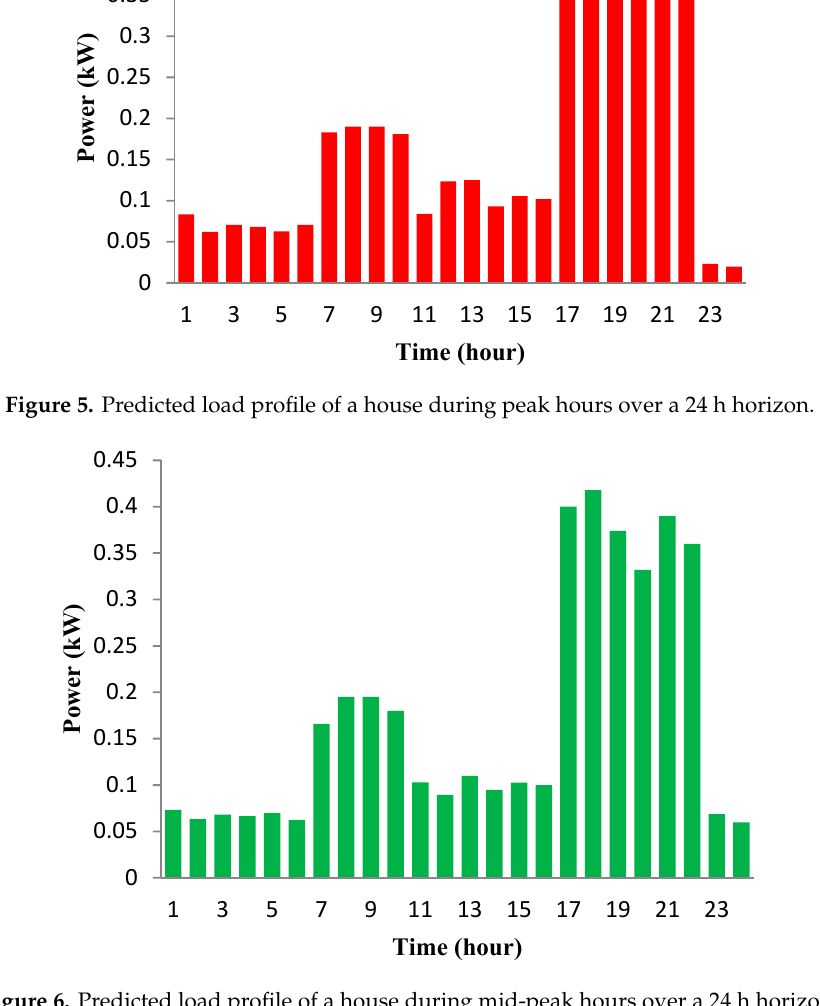
Figure 7. Predicted load profile of a house during off-peak hours over a 24 h horizon . Figure 8 indicates the real-time electricity prices for energy purchase per unit that is taken as a grid model in this study. These dynamic prices help electricity customers to schedule flexible loads, such as water heaters and washing machines. Electricity prices are generally announced an hour